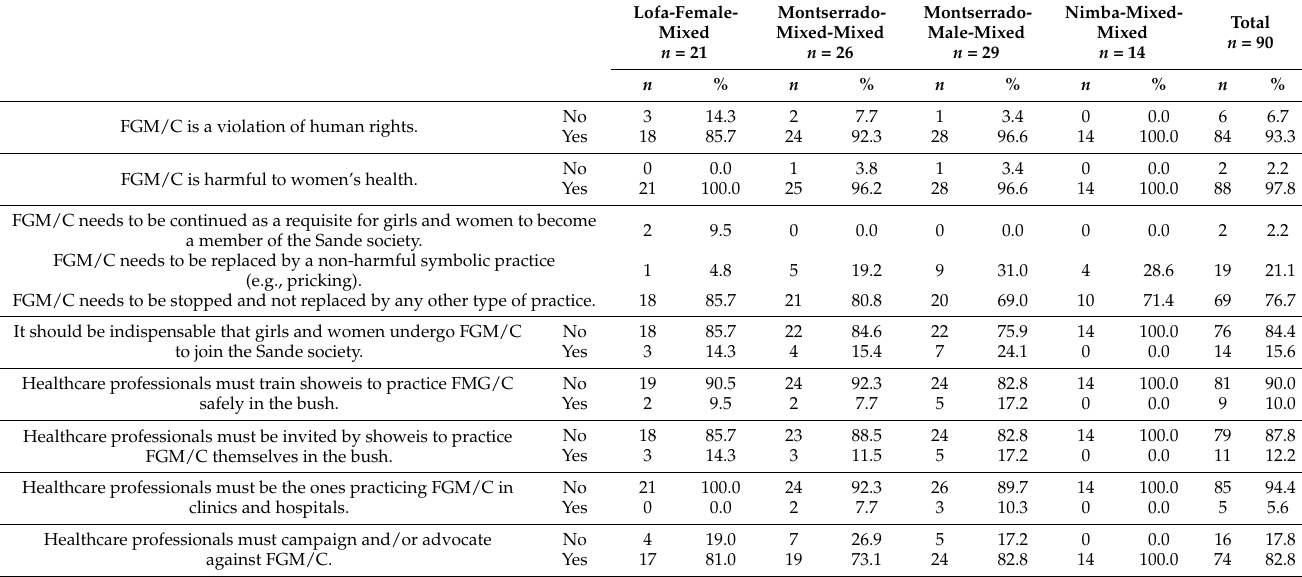
Table 2. Healthcare workers’ attitudes towards Female Genital